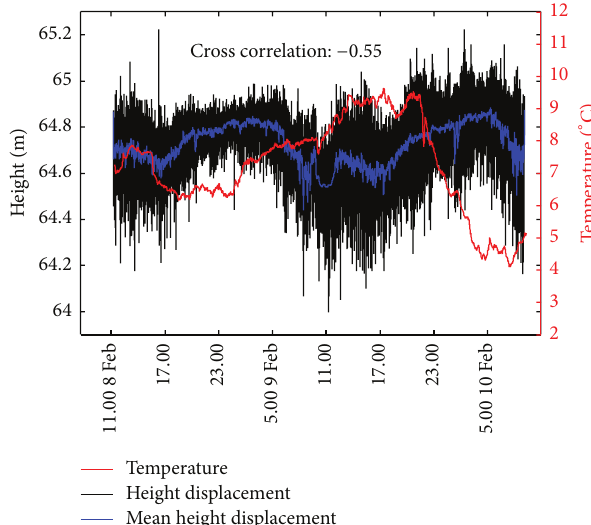
Figure 3: Relation between the air temperature and height deflec- tion at site